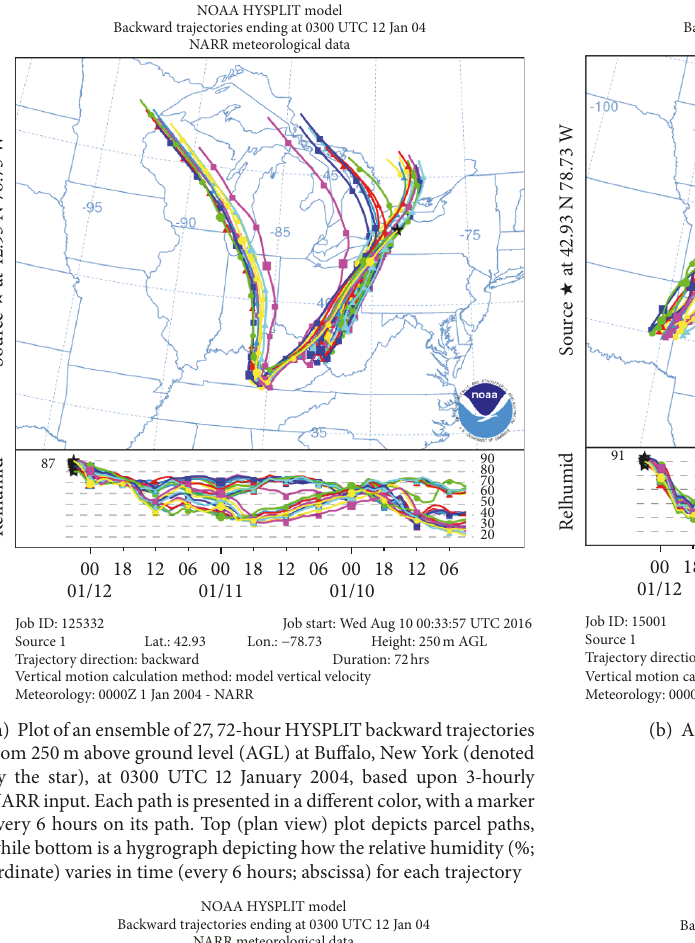
Trajectory direction: backward